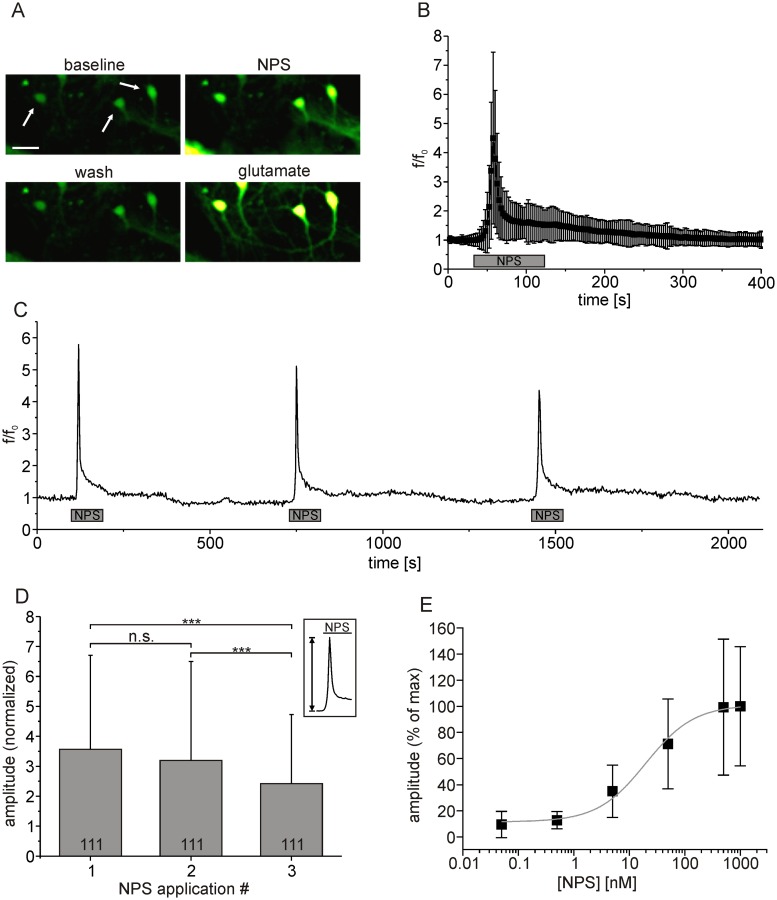
NPS-evoked calcium signals in hippocampus neurons expressing NPSR1.(A) Mean fluorescence images of Fluo4-stained hippocampus neurons transfected with AAV-NPSR1-TS-mCherry-ER during baseline-conditions, application of 500 nM NPS, washout and application of 300 μM glutamate. Arrows mark NPS-responsive neurons. Mean fluorescence images were calculated from seven raw images each. Scale bar indicates 25 μm. (B) Normalized mean fluorescence values for the first NPS-administration calculated from 229 individual neurons after peak alignment. (C) Fluorescence trace of a single NPSR1-expressing neuron stained with Fluo4-AM. NPS [500 nM] was applied for 90 seconds as indicated. (D) Comparison of normalized peak amplitudes for three consecutive applications of NPS. (E) Dose-response curve for NPSR1-mediated calcium mobilization in neurons, depicting an EC50 of 19.8 ± 1.3 (SEM, n = 318 neurons).